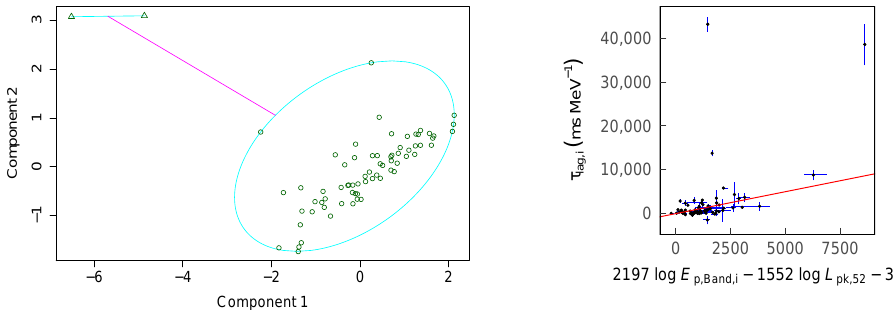
) × log E − p,Band,i 390